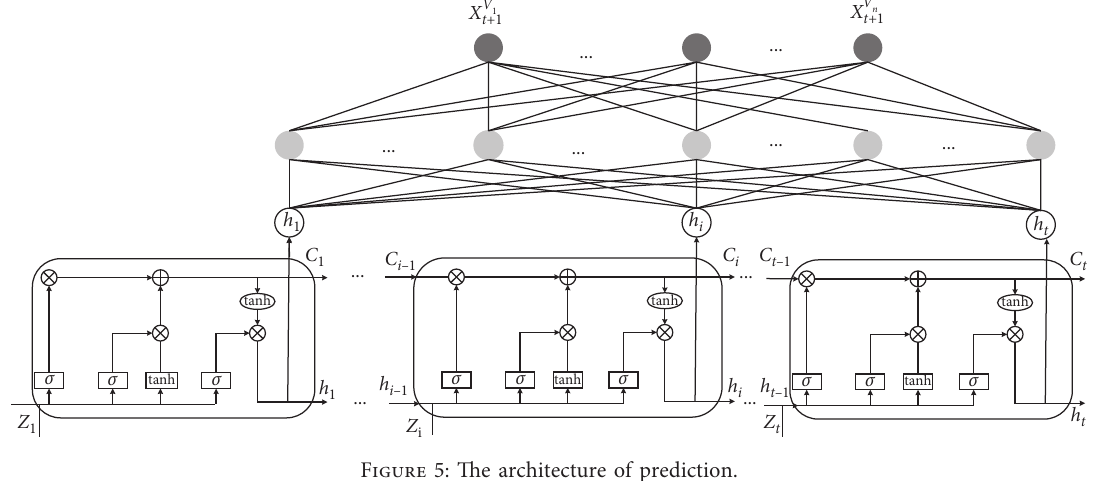
Figure 5: The architecture of